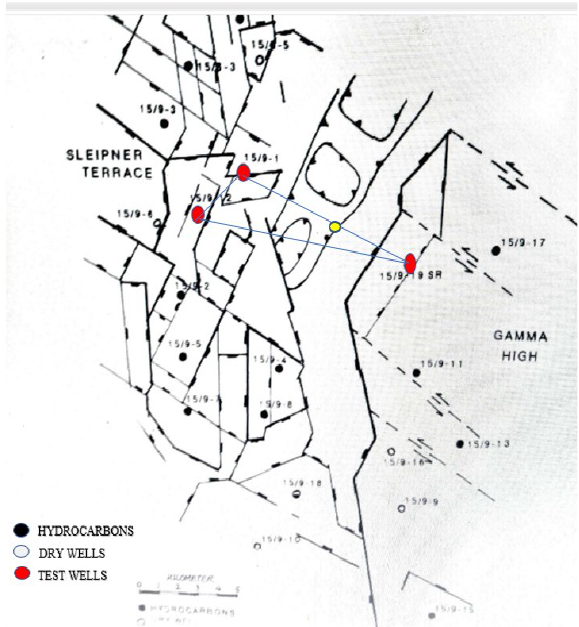
Figure 2. Map displaying the location of various wells. black circle represent hydrocarbon well and the white one represents dry wells. Red circle are the test wells that have been used for testing the model. yellow circle depicts the origin. On scale unit, 3 cm. is equal to 5 km. (Figure was modified. (Equinor,2018)) Well 15/9 F-1, Well 15/9 F-12, Well 15/9